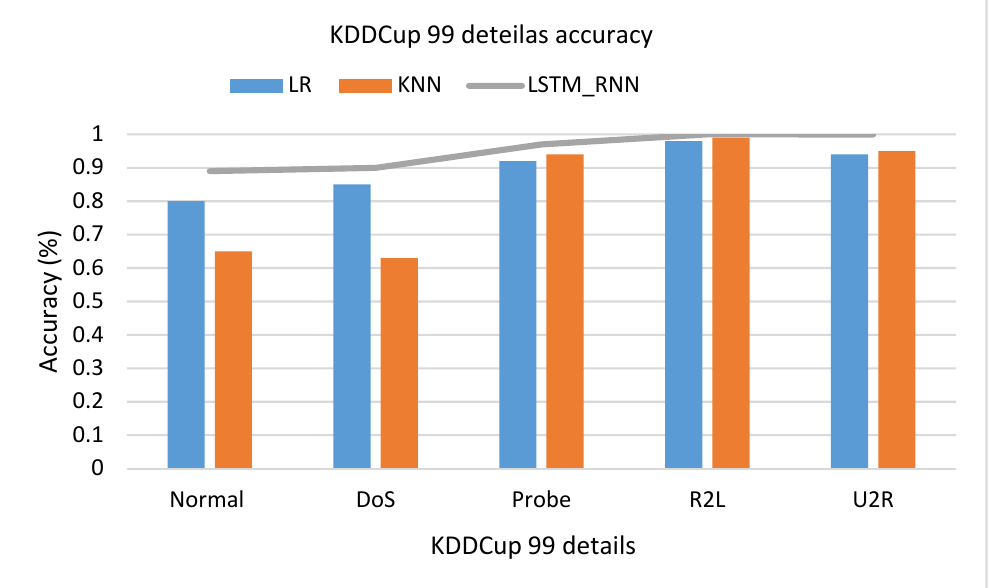
Figure 17. KDDCup 99 detailed classification details accuracy comparison.